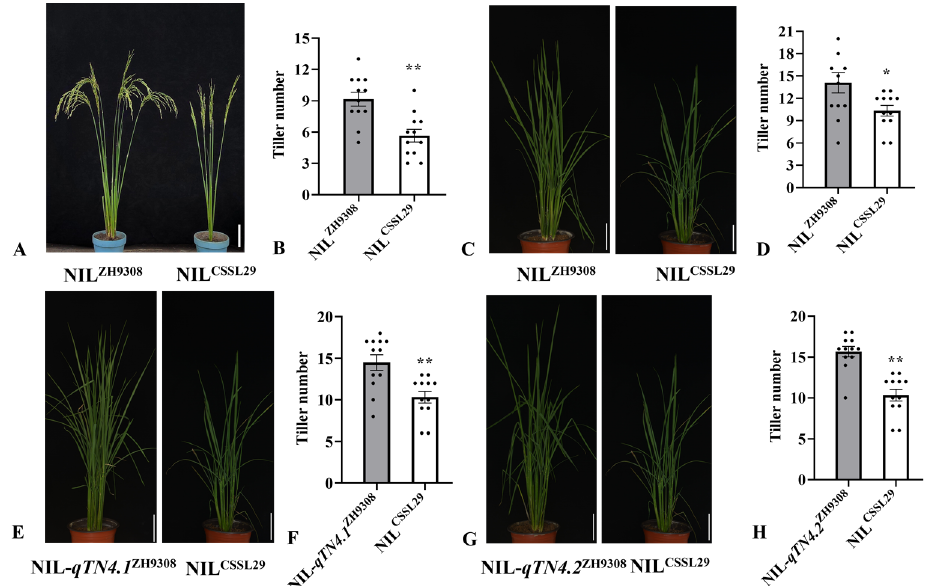
Figure 5. The phenotype of four NILs: ( A , B ) the phenotype of NIL ZH9308 and NIL CSSL29 at grain filling stage in Lingshui in 2021; ( C , D ) the phenotype of NIL ZH9308 and NIL CSSL29 at tillering stage in Fuyang in 2022; and ( E – H ) the phenotype of two QTLs’ NILs at tillering stage in Fuyang in 2022. The scale bar is 10 cm. Data are presented as means ± SEM. n = 24 in ( B ); n = 12 in ( D , F , H ). * p < 0.05, ** p < 0.01, Student’s t -test.